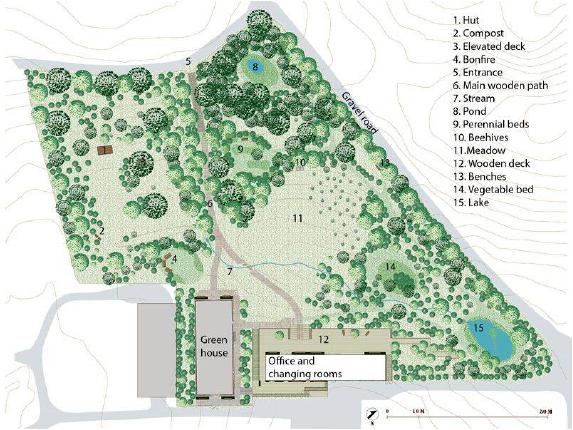
Figure 1. Figure one is a map of the therapy garden, Nacadia.